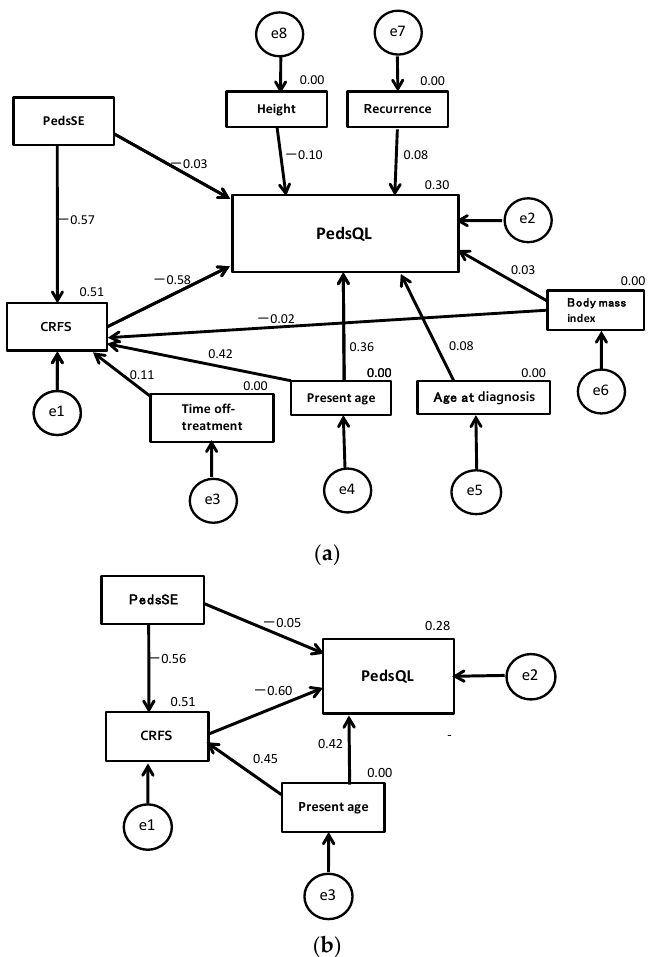
Figure 3. Structural equation models examining the influence of self-efficacy on cancer-related fatigue and health-related quality of life in childhood cancer survivors ( n = 46). The model ( a ) were constructed including all possible demographic and clinical confounders. The model ( b ) were constructed excluding all nonsignificant possible confounders (including “present age“ only) Table 3 shows Spearman’s rank correlation coefficients between each subscale of the CRFS and PedsSE or the PedsQL subscales in survivors of childhood cancer. The PedsSE had relatively strong negative correlations with “decreased function” (r = − 0.523) and “al- tered mood” (r = − 0.470), and “altered mood” had a relatively strong negative correlation with the PedsQL (r = − 0.737). Therefore, the main pathway from self-efficacy to HRQoL was thought to be mediated by the emotional aspect of cancer-related fatigue. Table 3. Correlations between each subscale of the CRFS and PedsSE or the PedsQL subscales in childhood cancer survivors ( n = 46).